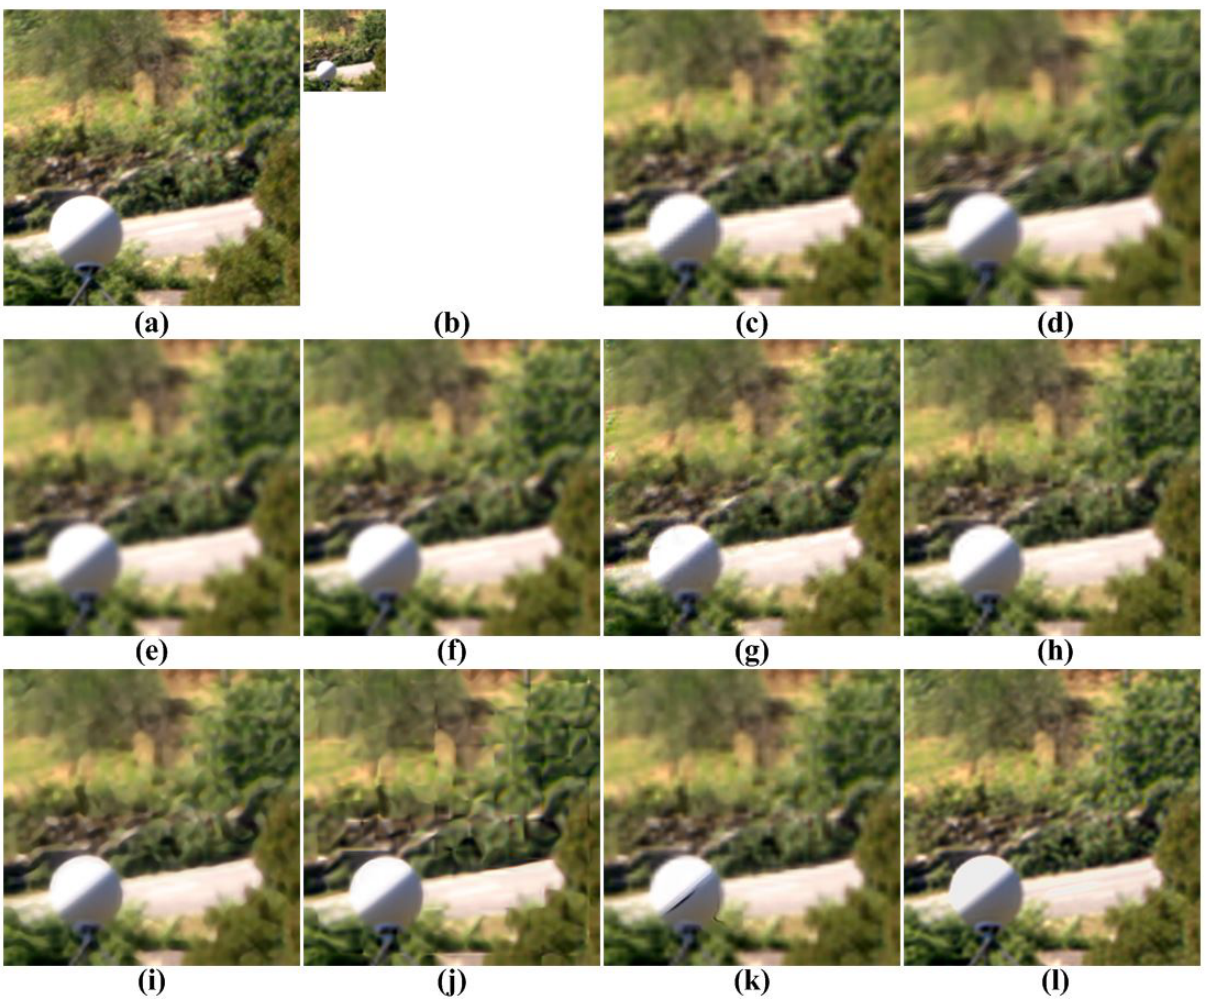
Figure 8. Results of resolution enhancement by enlarging a simulated LR multispectral image: ( a ) cropped original HR image in Figure 4d; ( b ) the four-times down-sampled LR image; results of: ( c ) cubic-spline interpolation [3], ( d ) interpolation-based SR [4], ( e ) interpolation-based SR [5], ( f ) interpolation-based SR [6], ( g ) example-based SR [7], ( h ) patch-based SR [9], ( i ) patch-based SR [10], ( j ) patch-based SR [11], ( k ) patch-based SR [12] and ( l ) the proposed